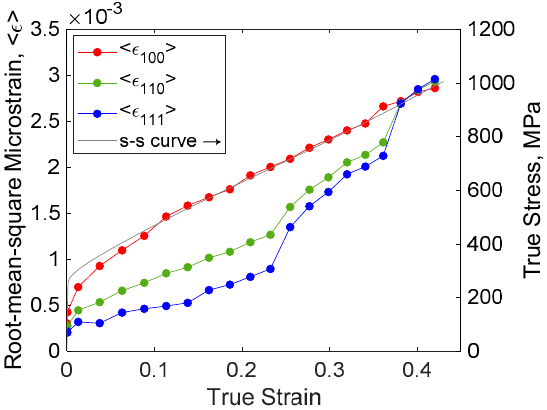
Figure 7. Development of microstrain (cid:104) ε hkl (cid:105) along < 100 > , < 110 > , and < 111 > as a function of true strain. The ranges and scales for the left and right vertical axes were arbitrarily determined to show the qualitative correspondence. The standard uncertainties for microstrain were smaller than the markers (i.e., < 2 × 10 − 5 ).